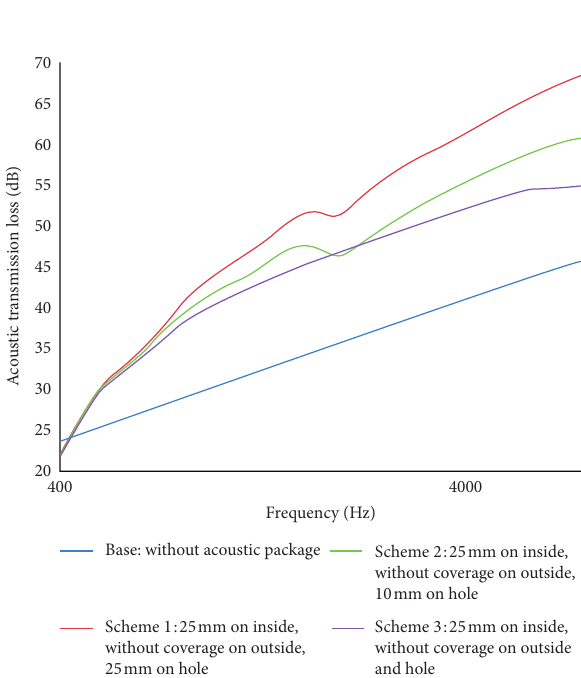
Figure 9: Impact of coverage of sound insulation